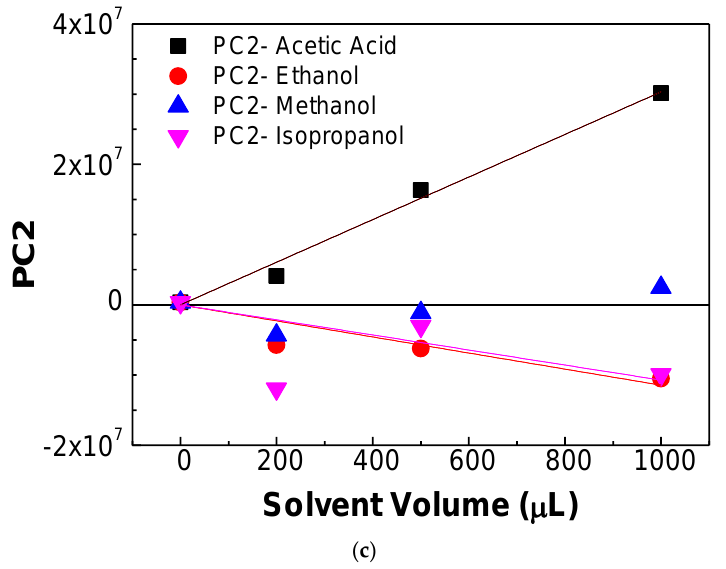
Figure 3. ( a ) PCA score plot after analyzing all the measured data for the detection of acetic acid, ethanol, methanol, and isopropanol in air at different concentrations; ( b ) evolution of PC1 components as a function of solvent volume; ( c ) evolution of PC2 components as a function of solvent volume.